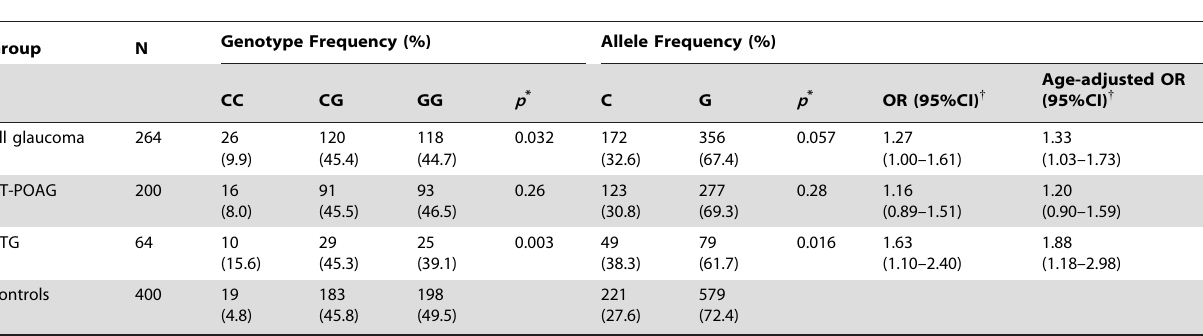
Table 2. Association of p53 codon 72 variant with NTG in the US (MEEI) cohort.